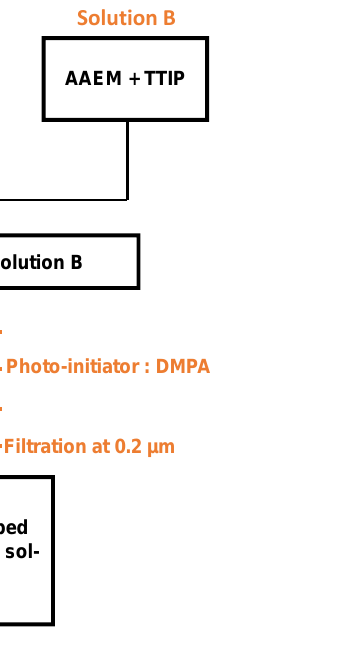
Figure 1. Elaboration of the TiO 2 -SiO 2 sol-gel doped with Rhodamine 6G (R6G) in the form of 1wt.%. R6G is pre-dissolved in ethanol before incorporation in the solution. Adapted from [26].